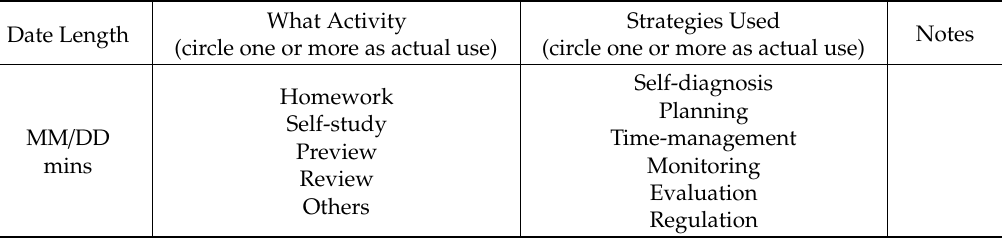
Table A2. Application worksheet for the teacher-led group.